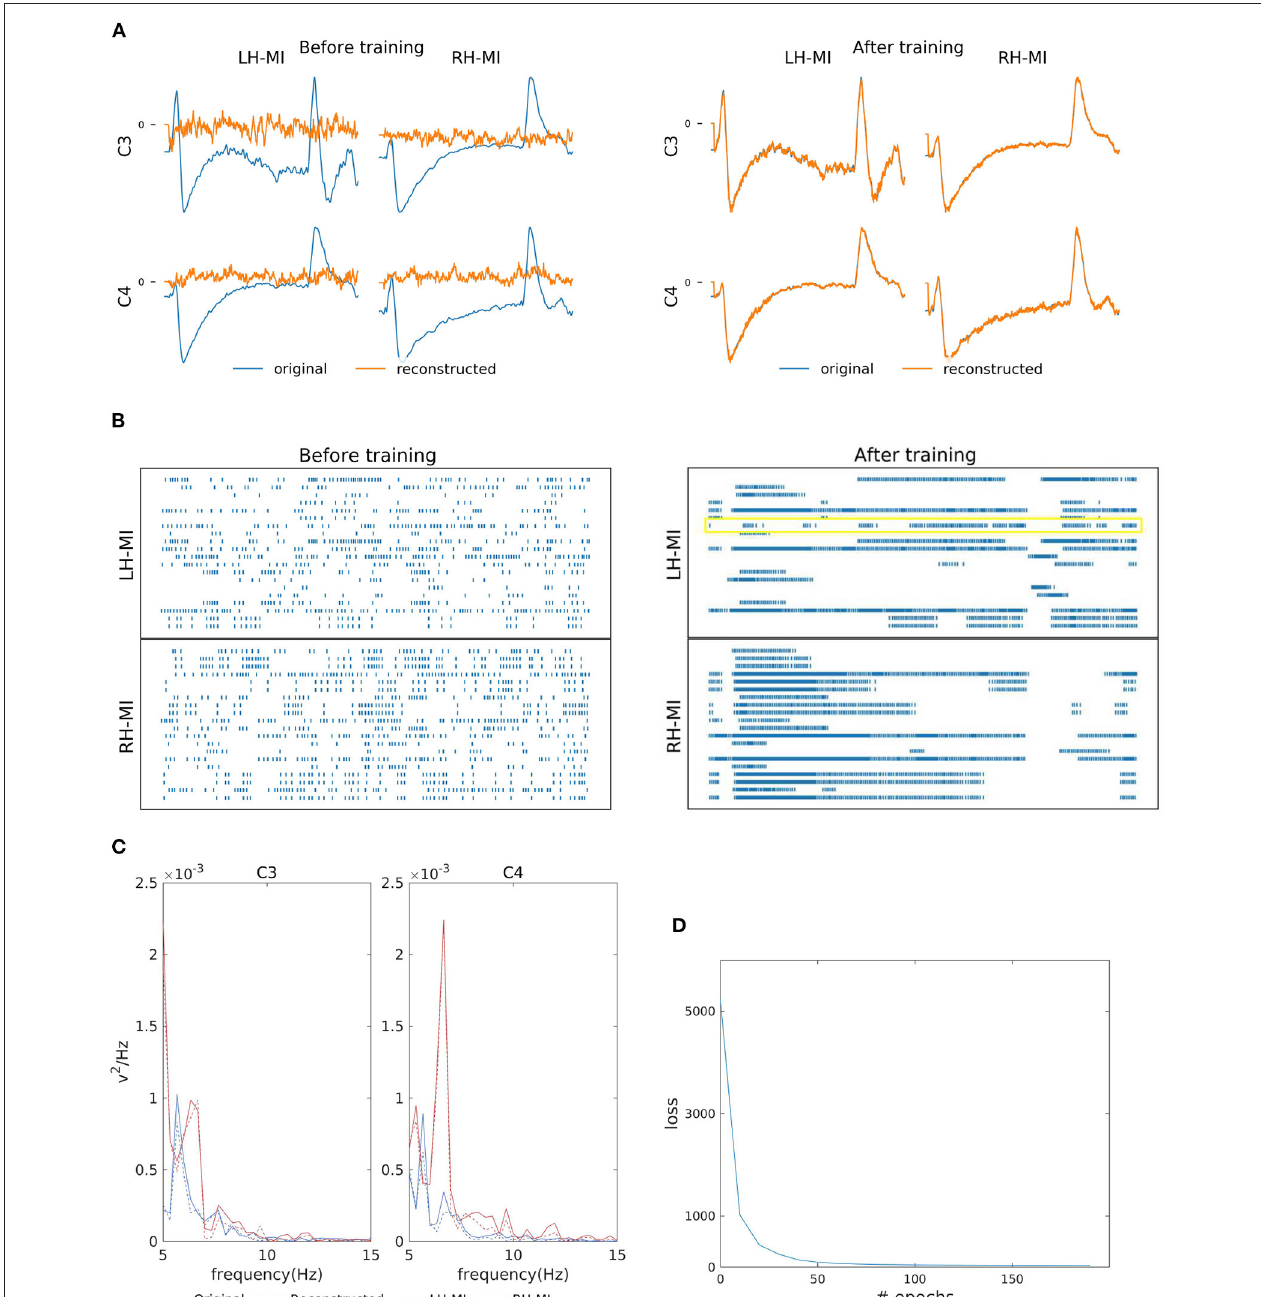
FIGURE 3 | Left-Hand-MI (LH-MI) and Right-Hand MI (RH-MI ) EEG signal reconstruction outcomes. (A) Illustration of original (blue line) and reconstructed (red line) C3 and C4 EEG signals for LH-MI and RH-MI tasks before and after SNN training. (B) Raster plot of 20 randomly selected neuronal spike trains from the hidden layer corresponding to both classes before and after training. The yellow box indicates the effectiveness of the training process in reorganizing the spike trains across layers. However, it should be noted that multiple neuronal spike trains rather than a single neuron contribute to the expected output signal. (C) Original (bold line) and reconstructed (dashed line) signal power spectrum at C3 and C4 channels for LH-MI (blue) and RH-MI (red), which appear to be fairly similar. (D) The loss value, i.e., the MSE, decreased substantially within a few epochs of the training process.